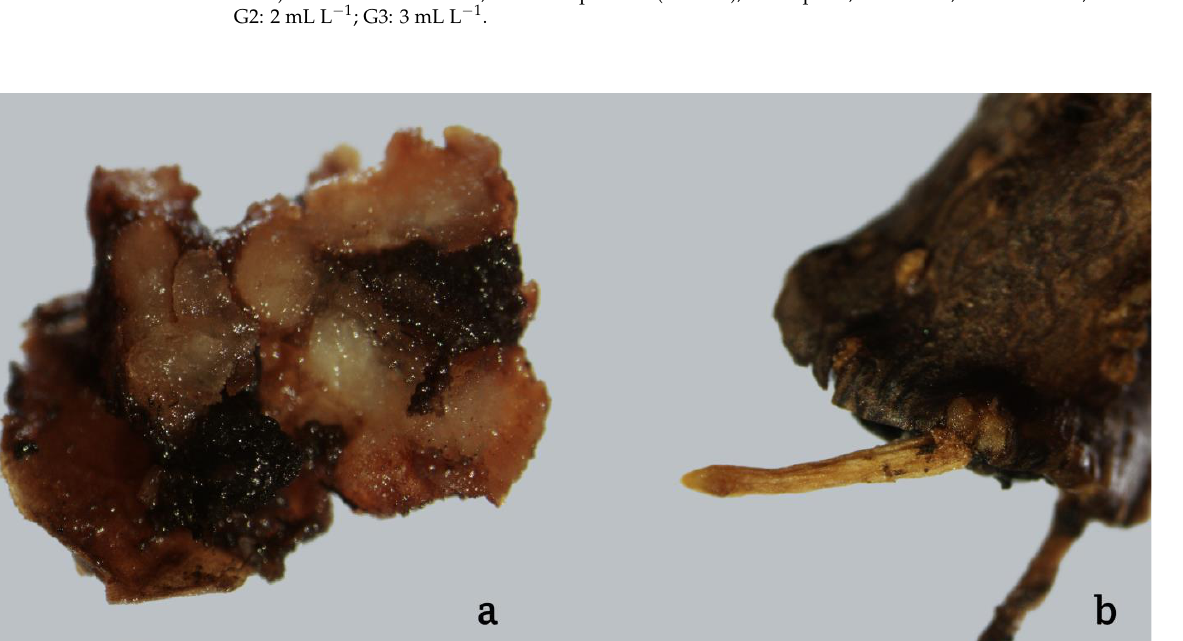
Figure 1. On the left ( a ) the production of callous tissue in G2 treated cutting; on the right ( b ) the adventitious root in R1 treated cutting. Table 2. Callused and rooted cutting (%) at 100 and 240 DAC in P. x fraseri ‘Red Robin’ influenced by rooting promoters concentration (RPC). Cuttings (%) RPC